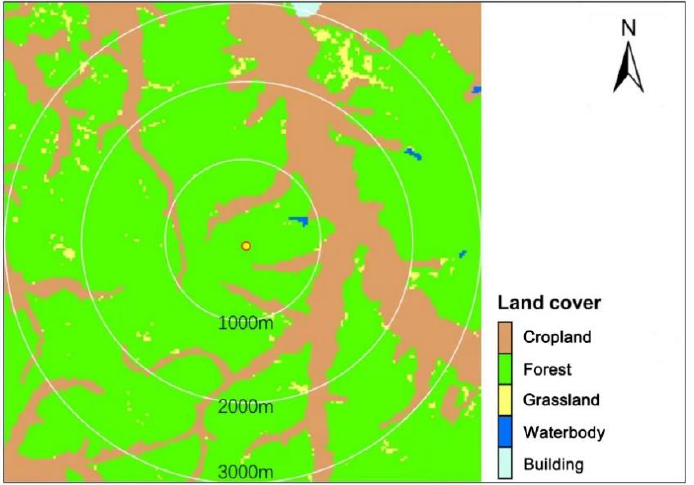
Figure 3. The land cover map over the flux site. In a 6 × 6 km grid around the flux tower, the study area was mainly composed of forest (coniferous plantation, 70.08%), cropland (double-cropped rice, 27.83%), grassland (1.84%), waterbody (0.11%) and building (0.14%).